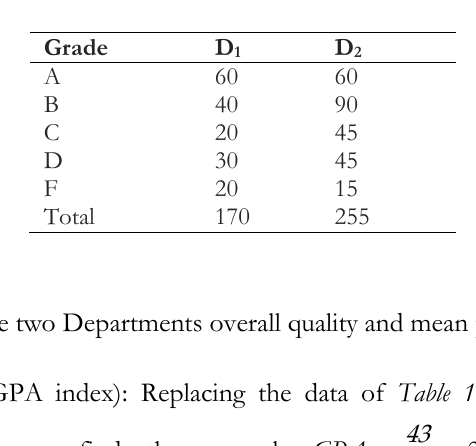
Table 1. Student performance in terms of the linguistic